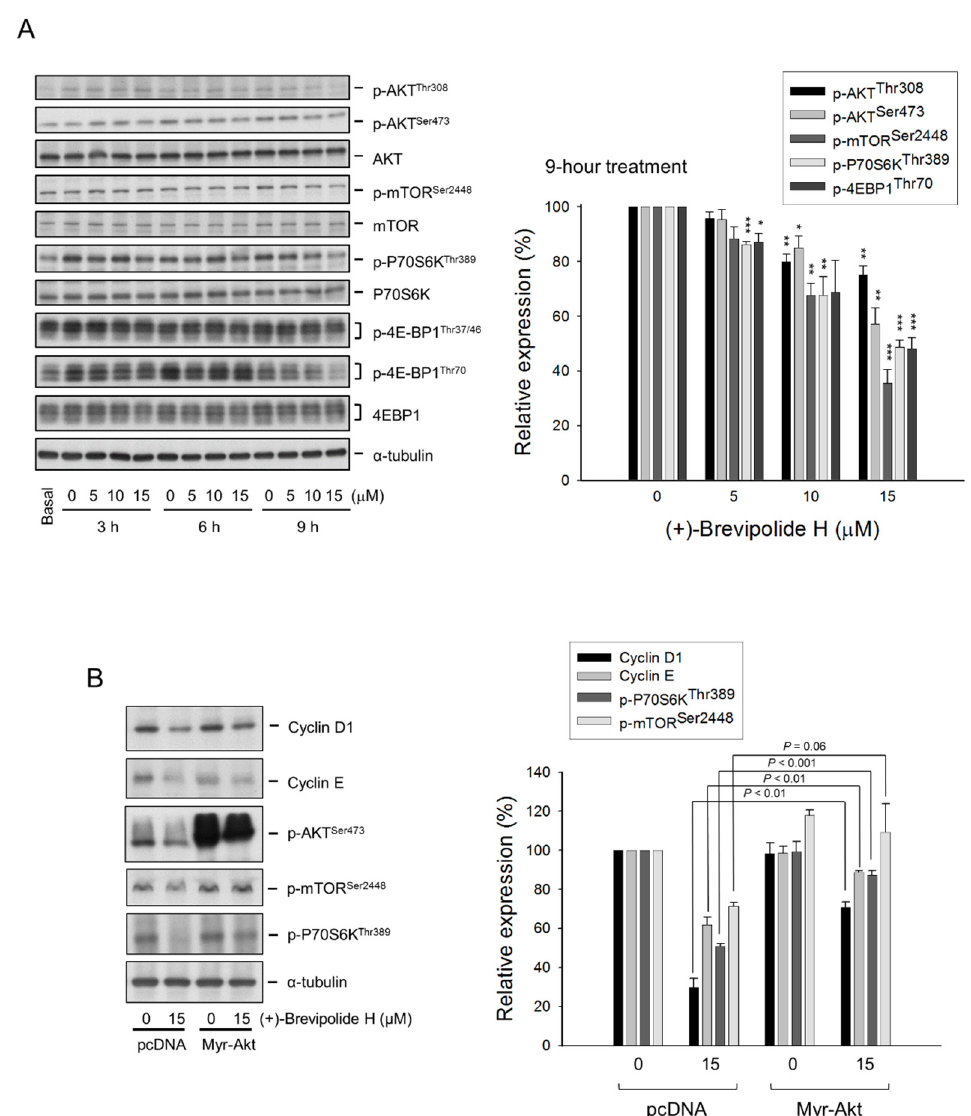
Figure 4. E ff ect of ( + )-brevipolide H on the expressions of Akt / mTOR / p70S6K pathway proteins. ( A ) PC-3 cells were incubated in the absence or presence of ( + )-brevipolide H for the indicated concentrations and times. The cells were then collected and lysed for the detection of protein expression by Western blot analysis. Quantitative data under the 9-h treatment are expressed as mean ± SEM of three independent experiments using Bio-Rad Image Lab TM Software; * p < 0.05, ** p < 0.01, and *** p < 0.001 compared with the control. ( B ) PC-3 cells were transfected with control vector or Myr-Akt and treated without or with 15 µ M ( + )-brevipolide H for 9 h. The protein expression was examined using Western blot analysis. Quantitative data of the relative protein expression were analyzed using Bio-Rad Image Lab TM Software.